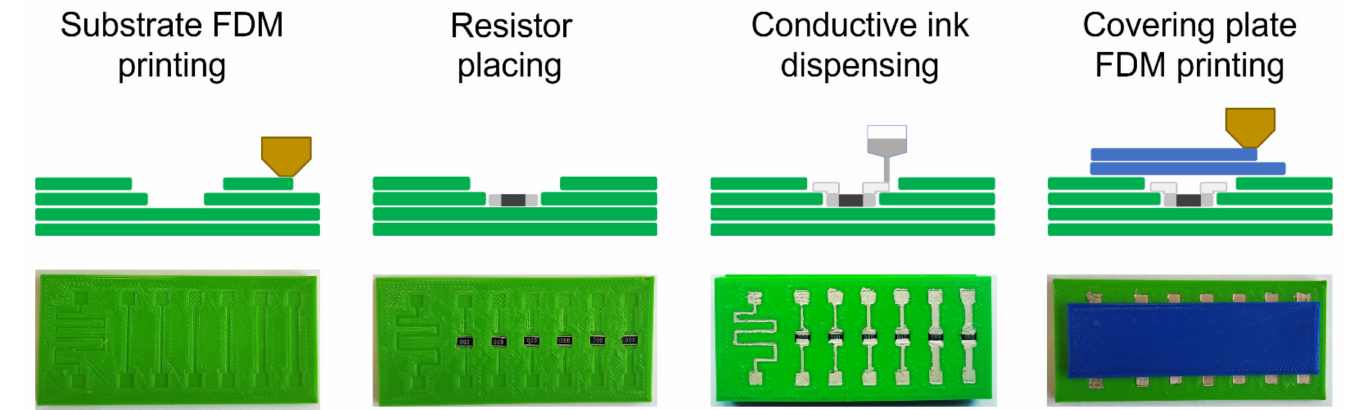
Figure 2. Fabrication steps of tested structural electronics samples and their appearance on each step.